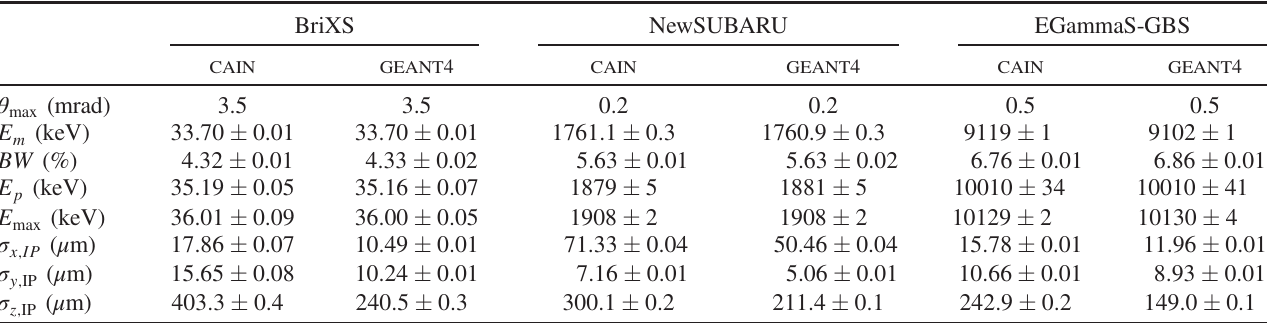
TABLE II. Comparison of the simulated photon beam with CAIN and GEANT 4 for the three cases considered. The first set of features are related to collimated beams, while the second set refers to the whole source rms size at the